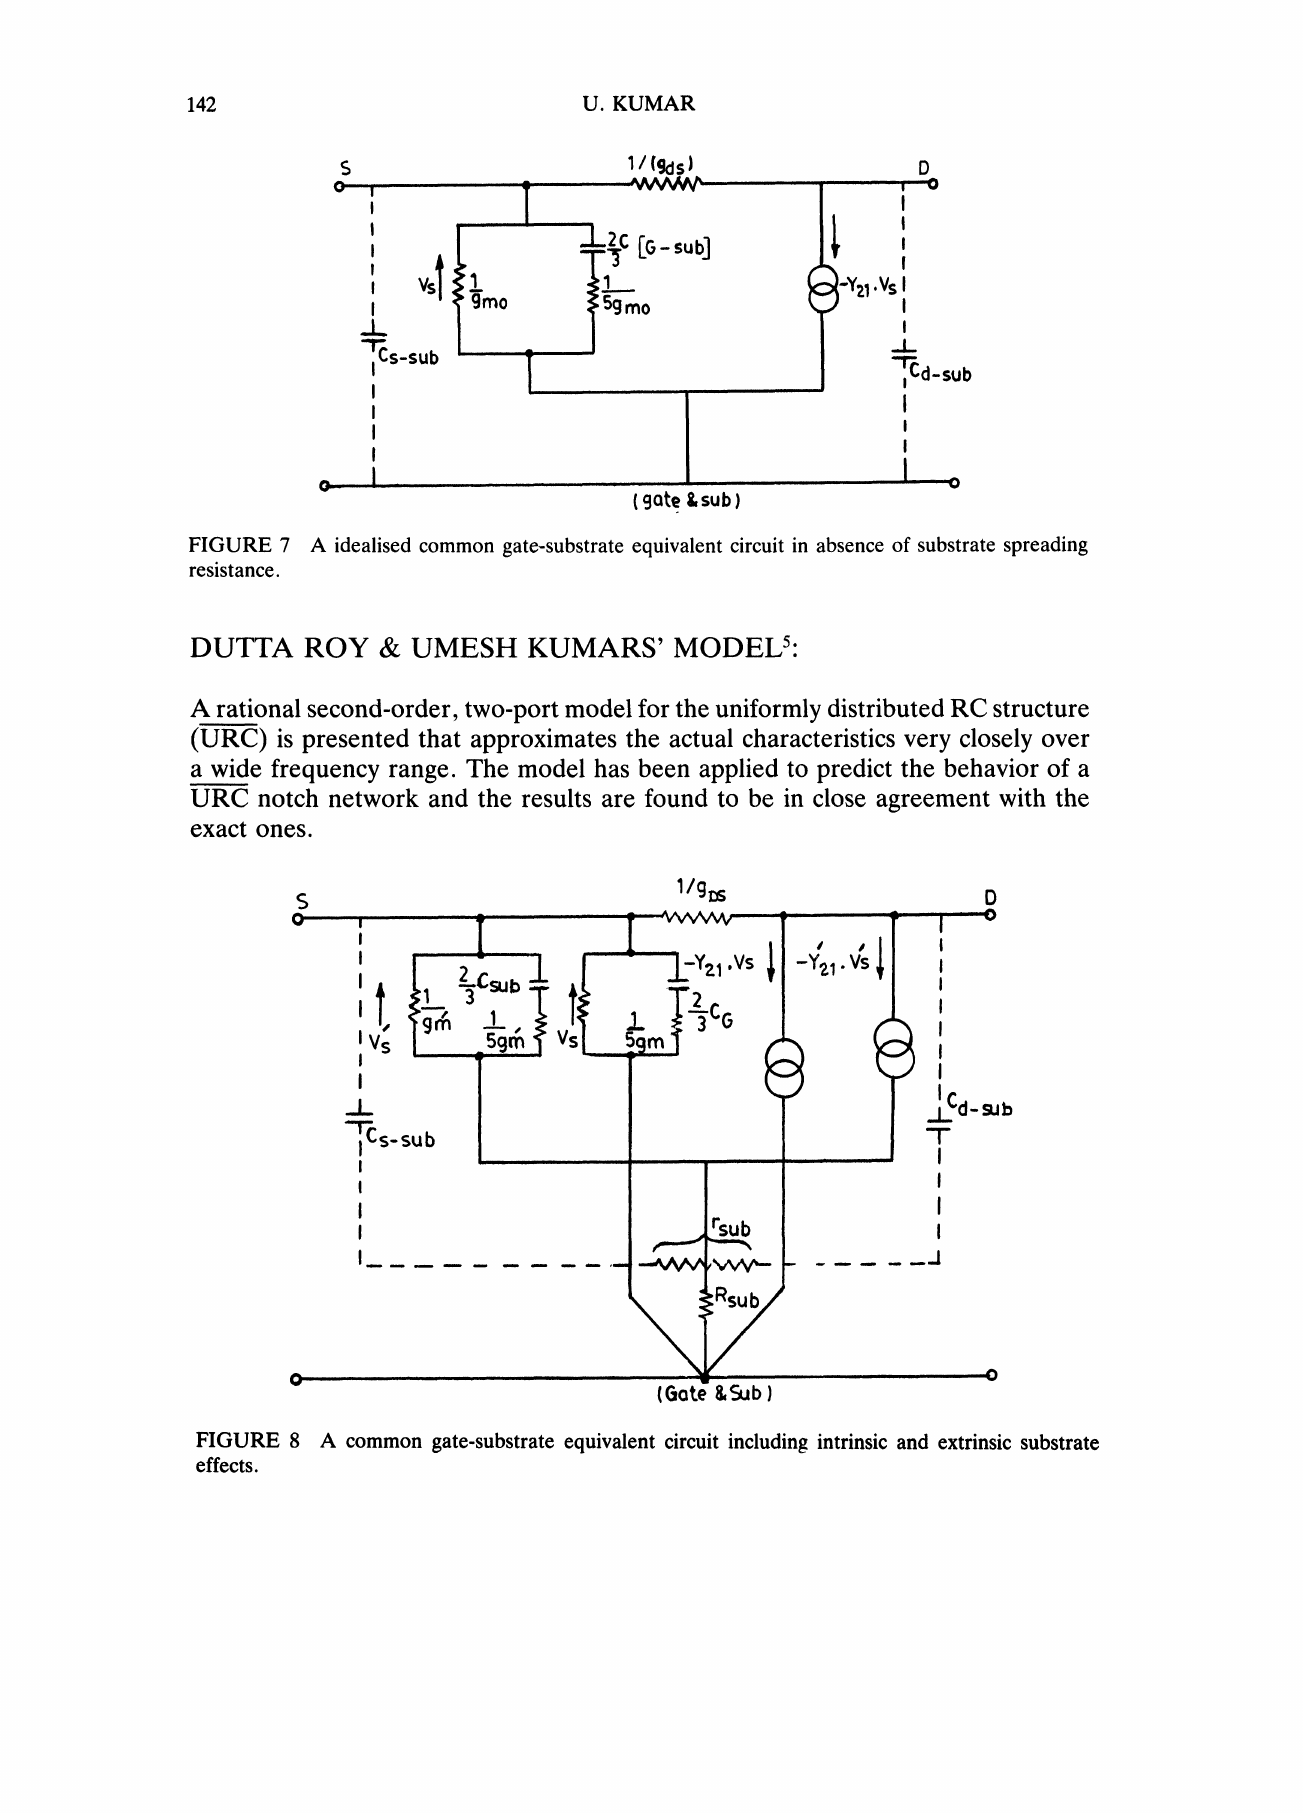
FIGURE 8 A common gate-substrate equivalent circuit including intrinsic and extrinsic substrate